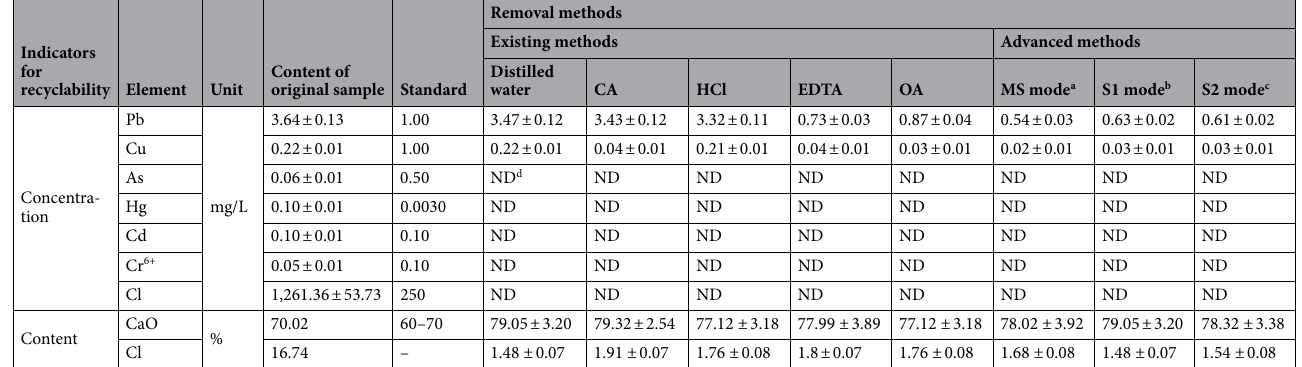
Table 6. The results of the recyclability assessment for the paper incineration ash following removal using various removal methods. a Removal using EDTA and OA simultaneously. b First step: EDTA; second step: OA. c First step: OA; second step: EDTA. d Not